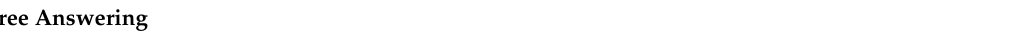
Table 6. Definition of free